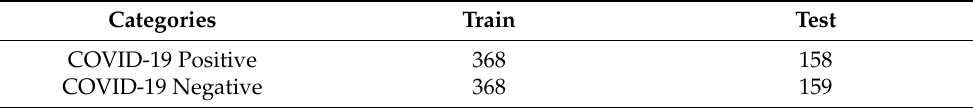
Table 3. Dataset Split for Cough Model (70:30